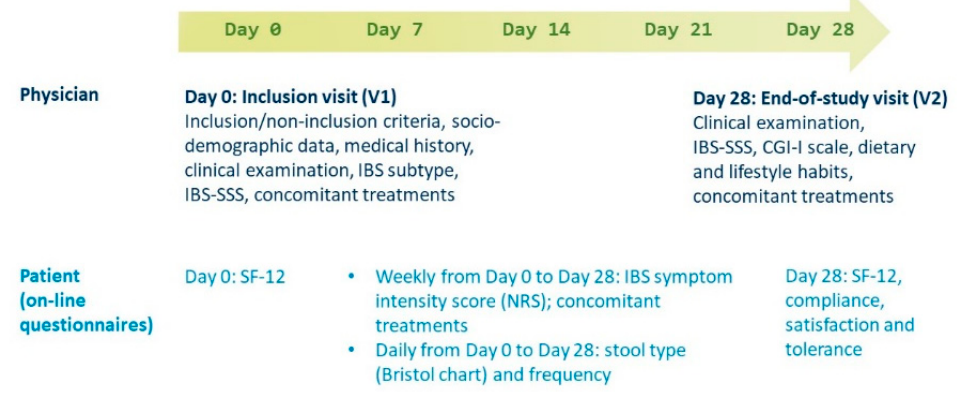
Figure 1. Study design. IBS-SSS, Irritable Bowel Syndrome Symptom Severity Scale; CGI-I scale, Clinical Global Impression of Improvement scale; SF-12, 12-item Short Form survey (quality of life questionnaire); V, visit; NRS, numeric rating scale.